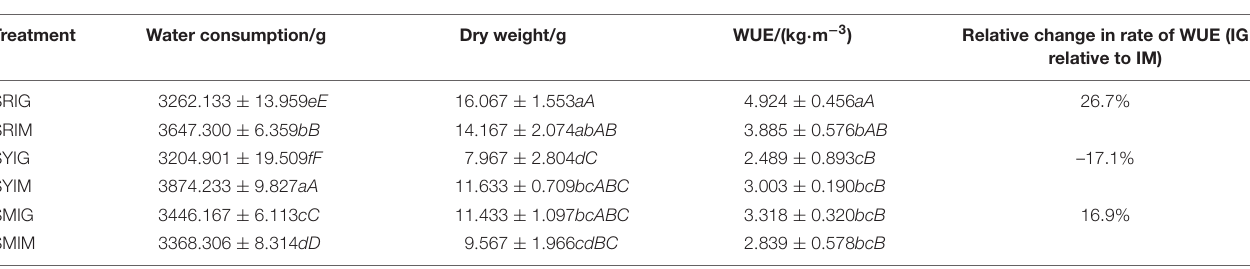
FIGURE 6 | Water consumption and soil water variation for pepper crop. The meaning of the “treatment condition codes SRIG, SRIM, SYIG, SYIM, SMIG and SMIM” is detailed in the notes with Figure 5 . (A) Root-zone micro-irrigation (IG); (B) surface drip irrigation (IM). TABLE 5 | Water-use efficiency (WUE) under different treatment conditions at